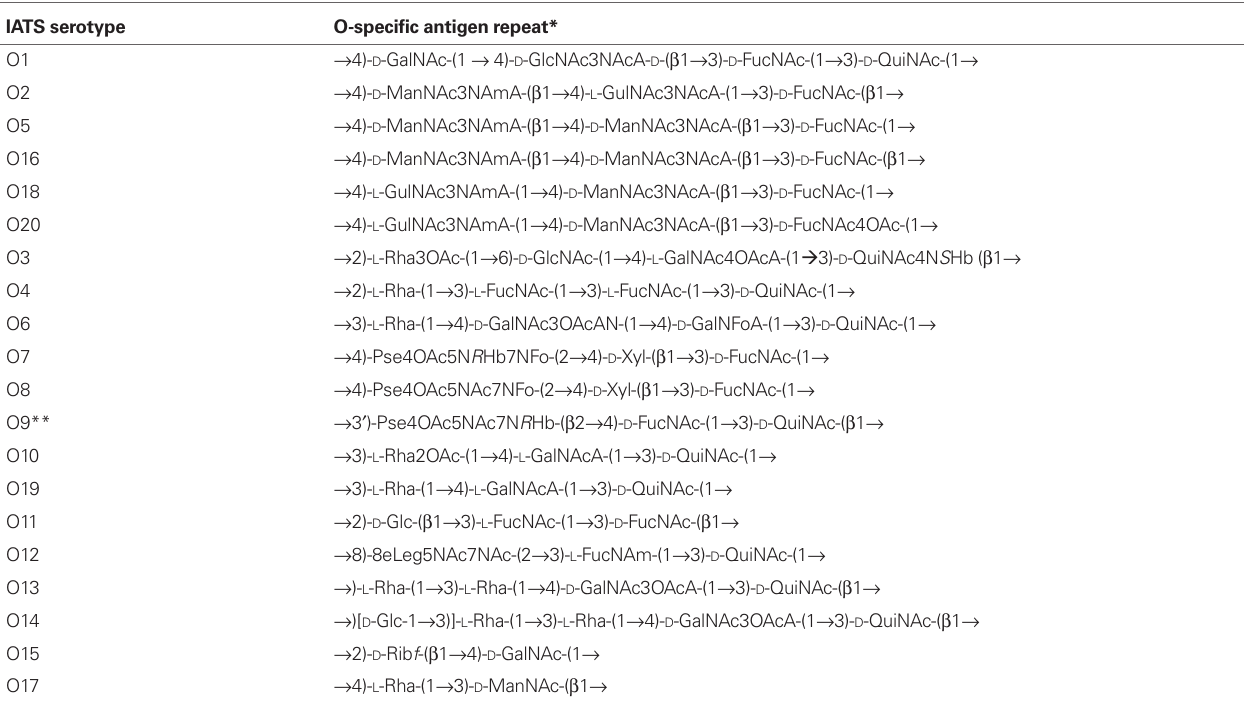
Table 1 | O-Antigen repeating units which compose the 20 IATS reference